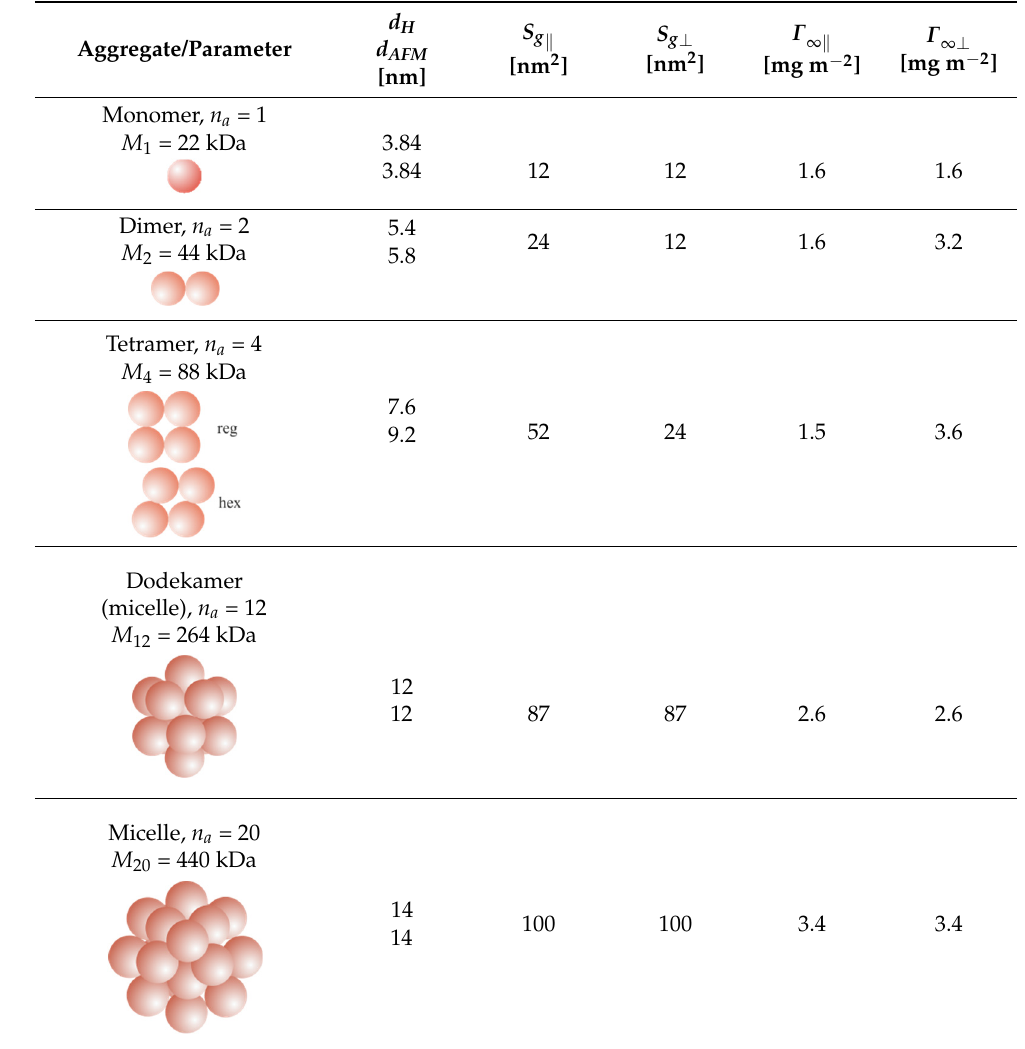
Table 2. Predicted physicochemical characteristics of S1R protein aggregates.